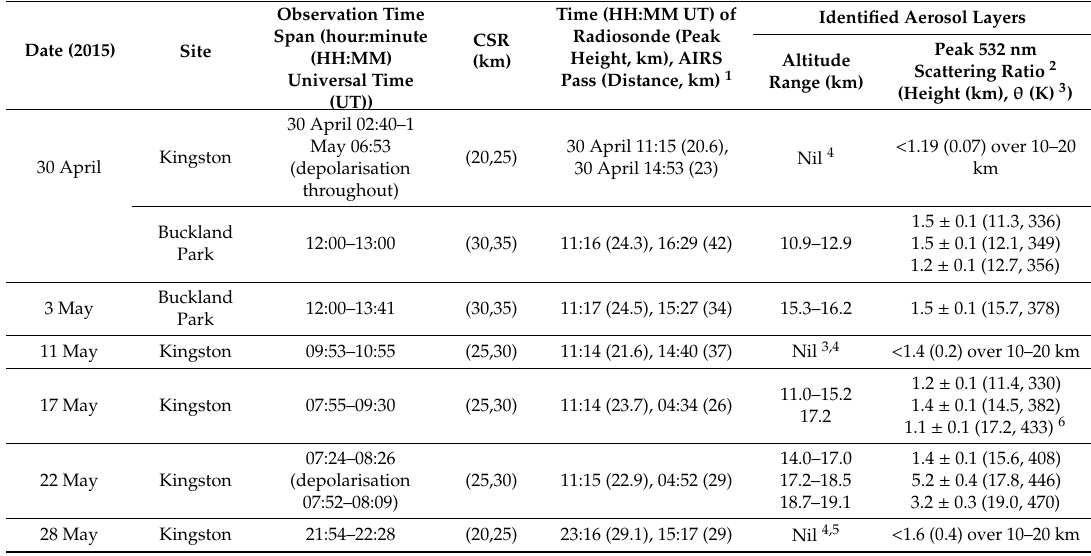
Table 2. Tropospheric and stratospheric observations from the Buckland Park and Kingston lidars